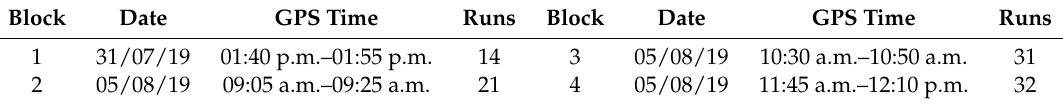
Figure 9. Realization of the plane-based calibration field for the calibration of mobile laser scanning systems ( left , middle). Mobile laser scanning system during the calibration measurements ( right ). Table 2. Time schedule of the 98 calibration runs, which were measured in July and August